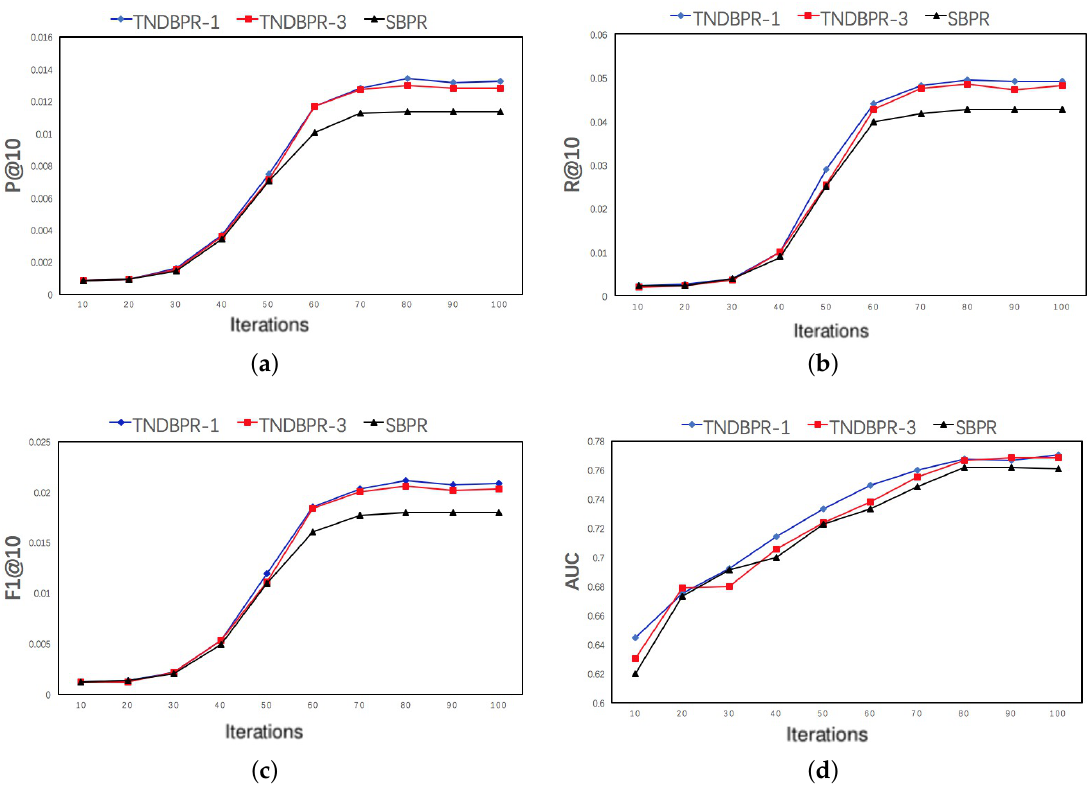
Figure 5. Convergence Analysis in Epinions DataSet: ( a ) effect on P@10 when varying the iteration; ( b ) effect on R@10 when varying the iteration; ( c ) effect on F1@10 when varying the iteration; and ( d ) effect on AUC when varying the iteration.